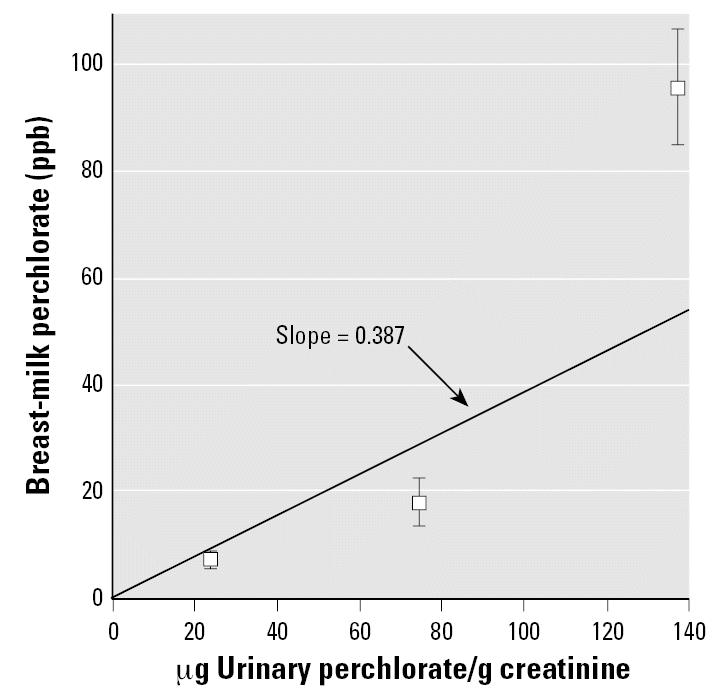
Mean (± SD) breast-milk perchlorate concentration in relation to mean urine perchlorate excretion. Data adapted from Tellez et al. (2005). Inverse invariance-weighted straight line constrained to pass through the origin.